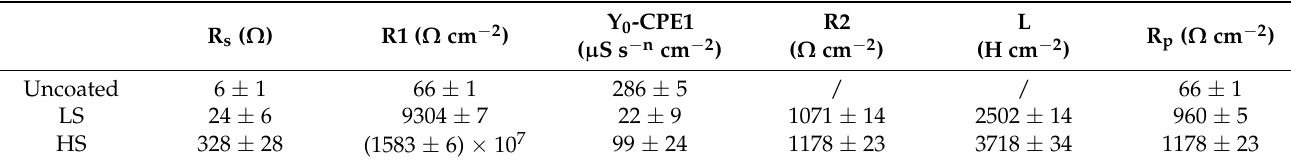
Figure 9. The equivalent circuit used to fit the EIS results of the uncoated ( a ), LS and HS ( b ) samples. Table 3. Impedance parameters of the uncoated, LS and HS samples in the 0.5 M HCl solution at 30 ◦